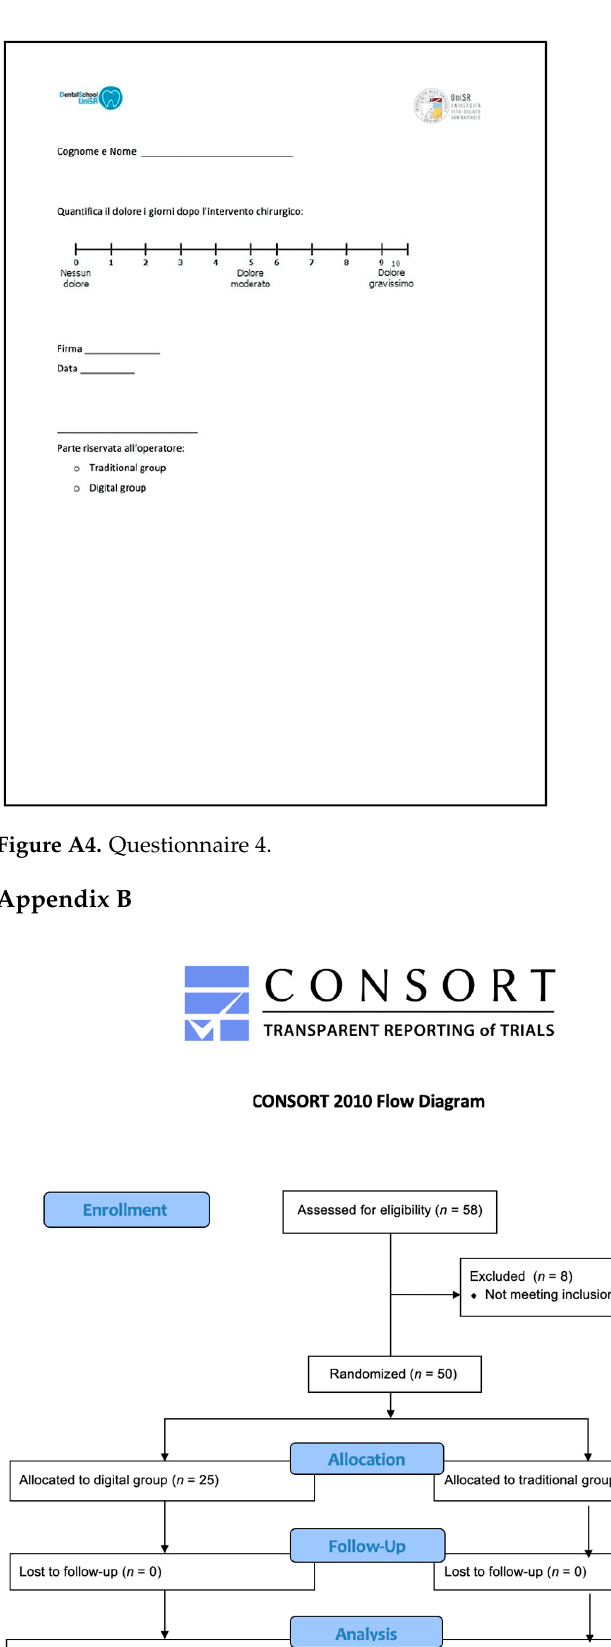
Figure A3. Questionnaire 3.